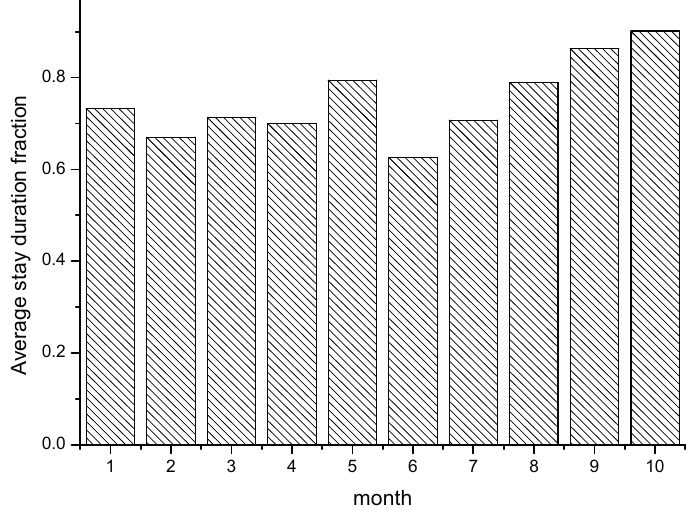
Figure 8. The self-adaptive average stay